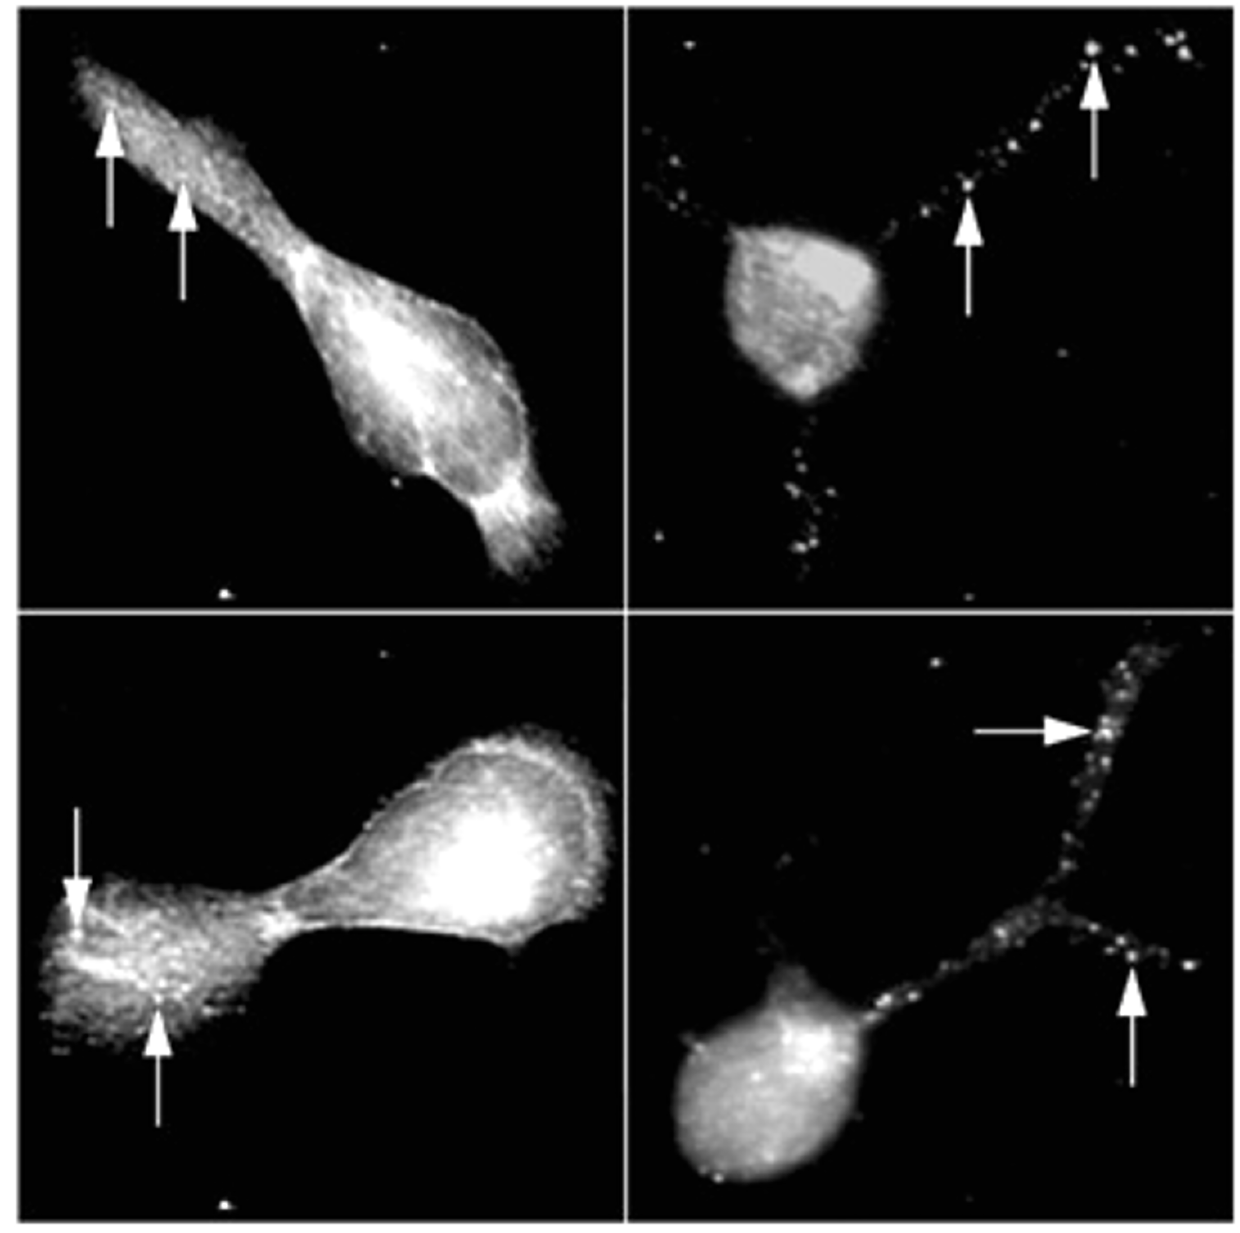
Punctate staining pattern of RhoA in untreated and C3 treated HPB-ALL cells. Cells were stained for RhoA as described in the Material and Methods . Untreated cells are in the left panels, and C3 treated cells are represented in the right panels. Arrows indicate punctate patterns of RhoA in HPB-ALL cells spreading on the extracellular matrix component